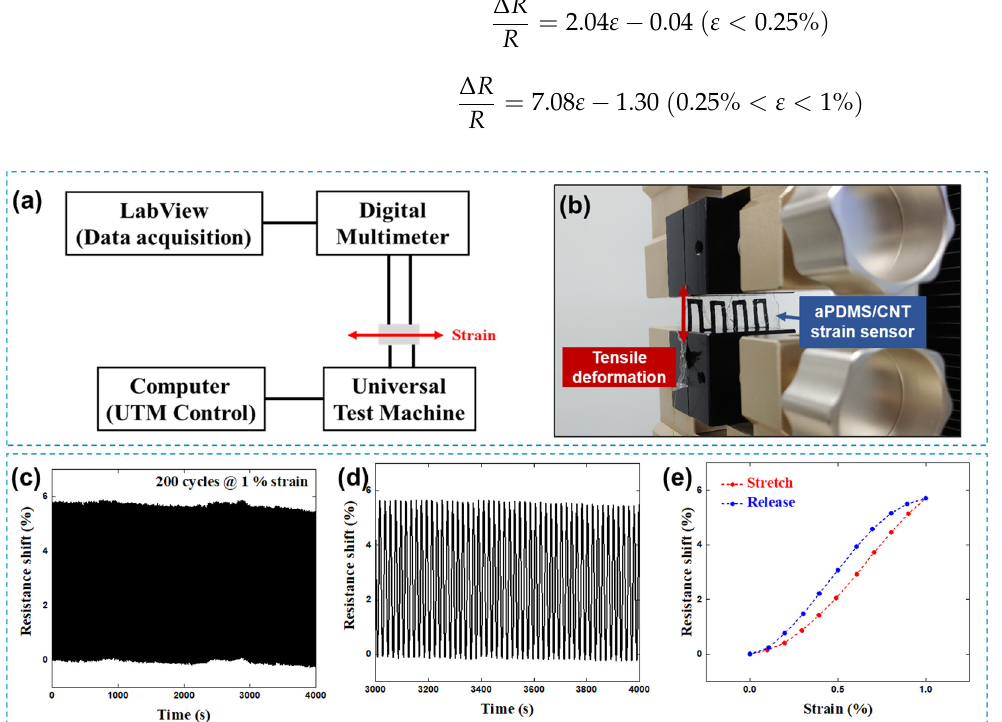
Figure 3. ( a ) Schematic and ( b ) a digital image of the tensile tester system consisting of a universal testing machine (UTM) and a digital multimeter; ( c , d ) shift in electrical resistance of an a-PDMS/CNT strain sensor under a repetitive 1% strain test; ( e ) shift in electrical resistance of the sensor under one cycle of stretch and release.